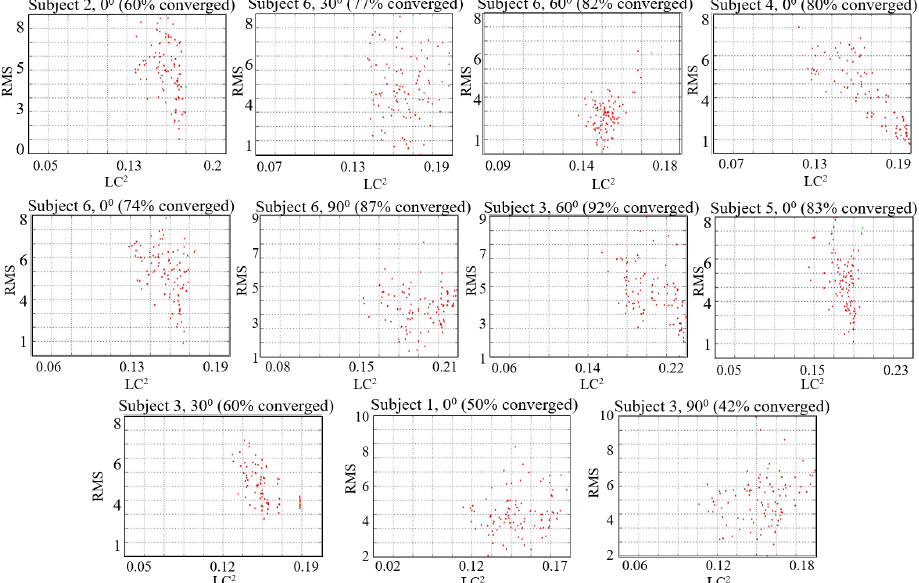
Figure 8. Random study registration results with 100 randomly initialized transformations for 11 subject cases along with the percentage of converged